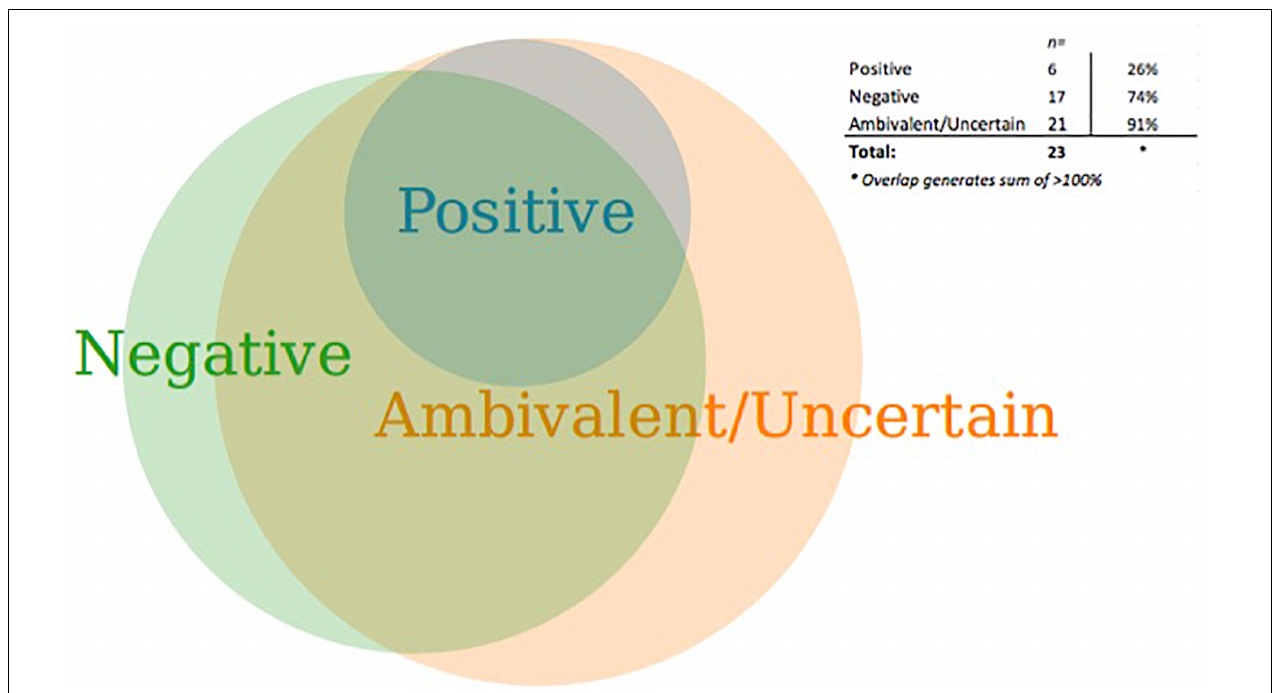
FIGURE 1 | Attitudes toward use of adaptive deep brain stimulation for